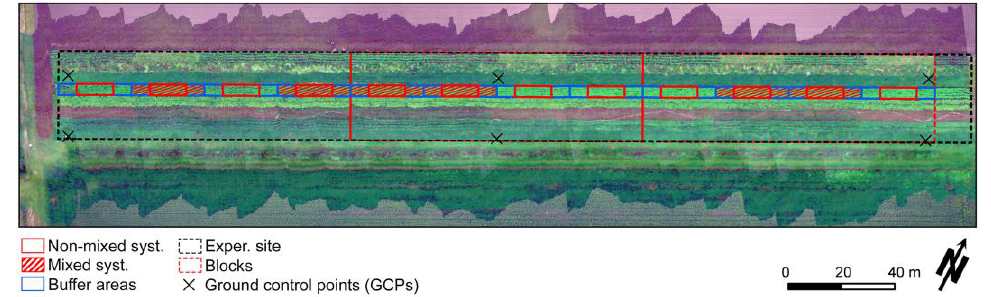
Figure 1. Location of the plots in the experimental area, represented over true color composite of a hyperspectral image, acquired in 24 June 2015. Bands centered at 665, 555 and 485 nm are used in the RGB representation, respectively.